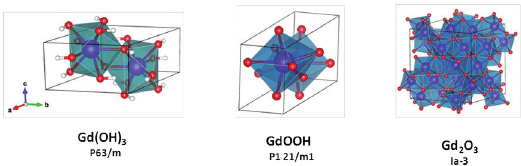
Figure 2: Schematic representation of the unit cells corresponding to the hexagonal, monoclinic and cubic structure of the materials. environments, and in general tend to form complex clusters with high coordination numbers, nine-coordination being particularly important in the structure of f -block elements 22 .